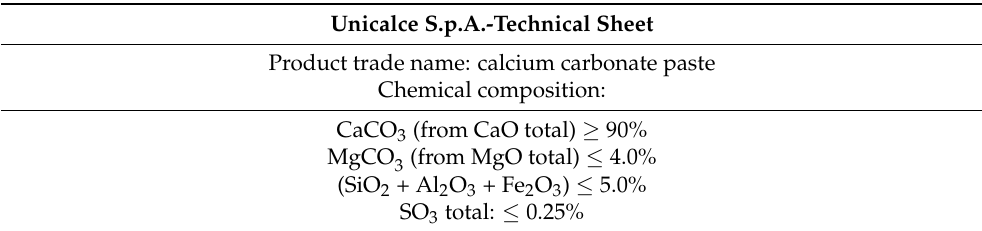
Table 2. Mineralogical and chemical composition of the buffering agent used in the tests. produced by the company Unicalce